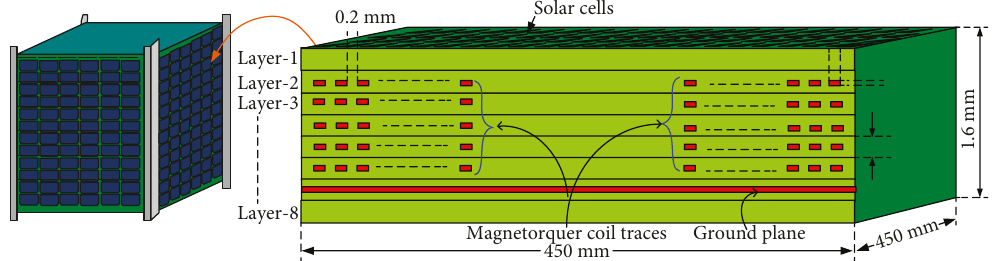
Figure 21: Solar panel module (PNSS-1) cross-sectional view with embedded magnetorquer.